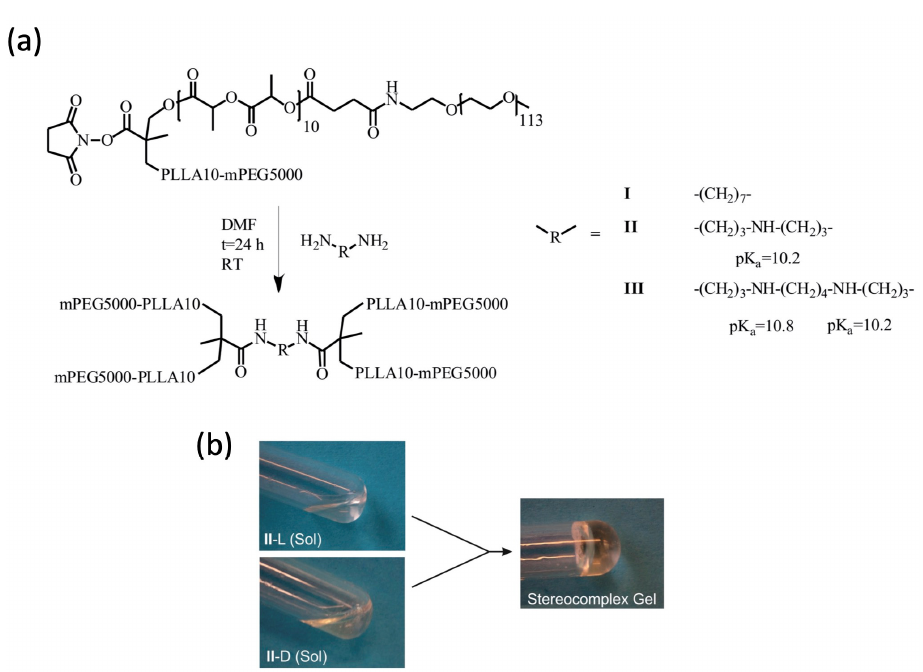
Figure 1. ( a ) Synthetic route for the preparation of four-arm copolymers I -L, II -L and III -L. The synthesis of I -D, II -D and III -D is analog. See Ref. [45] for details. ( b ) Example of gelation in PBS upon mixing 20 wt.% solutions of enantiomerically pure copolymers II -L and II -D.